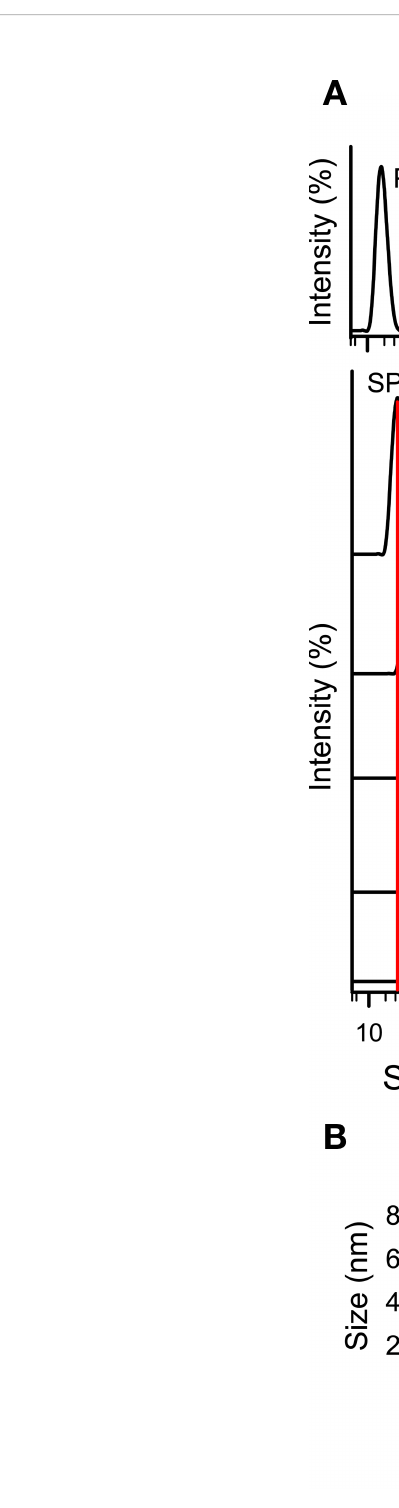
FIGURE 5 SP-A forms molecular aggregates with polymyxin B. The formation of SP-A and PMB complexes was examined by DLS. (A) DLS analysis of the hydrodynamic diameter of SP-A/PMB complexes in 5 mM Tris-HCl buffer (pH 7.4), in the presence or absence of 150 mM NaCl. The y-axis represents the relative intensity of the scattered light; the x-axis represents the hydrodynamic diameter of the particles present in the solution. DLS analyses of SP-A (15 nM) and PMB (15 m M) particles alone in both buffers are shown in the upper graphs. One representative experiment of four is shown. (B) Formation of SP-A/PMB aggregates is independent of salts. The results are the mean ± SD of four independent experiments, each in